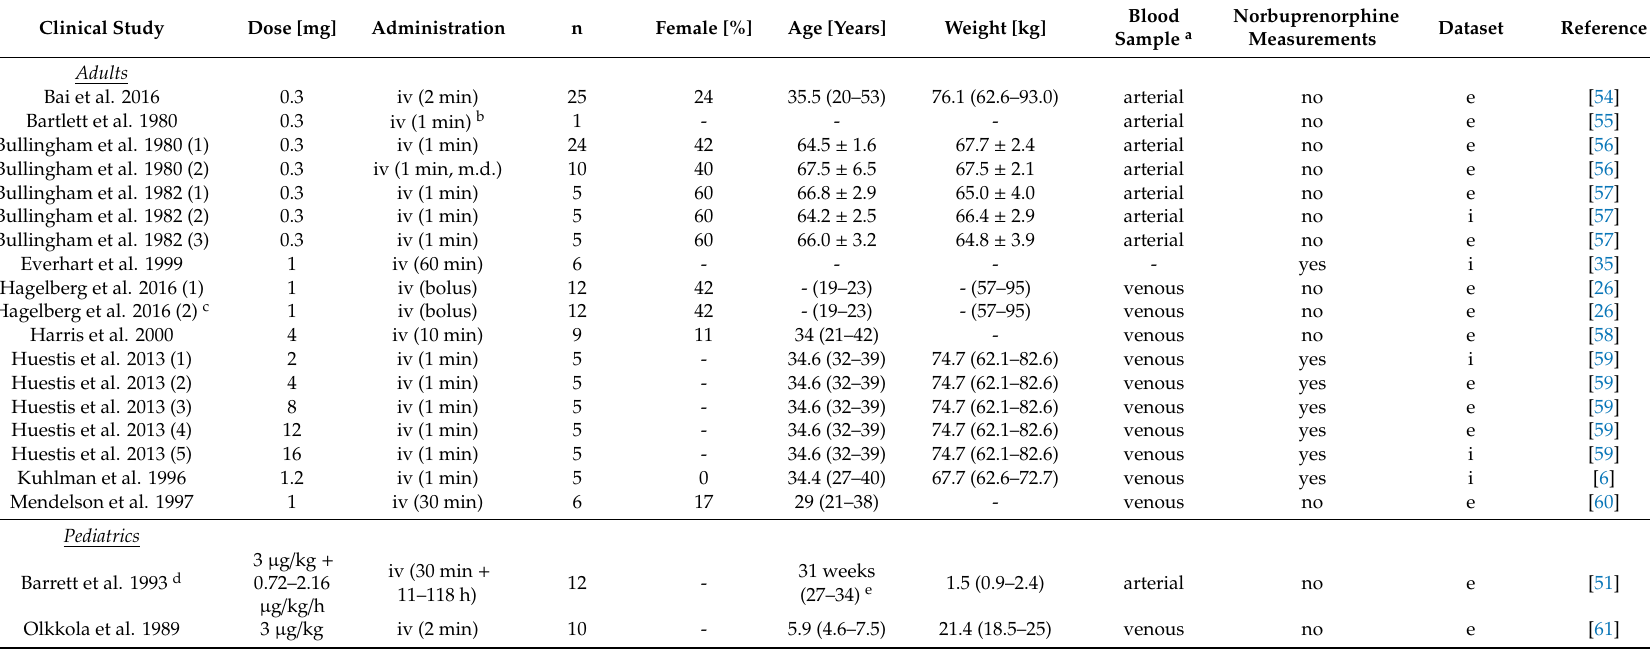
Table 1. Overview of clinical studies used for building and evaluation of the PBPK